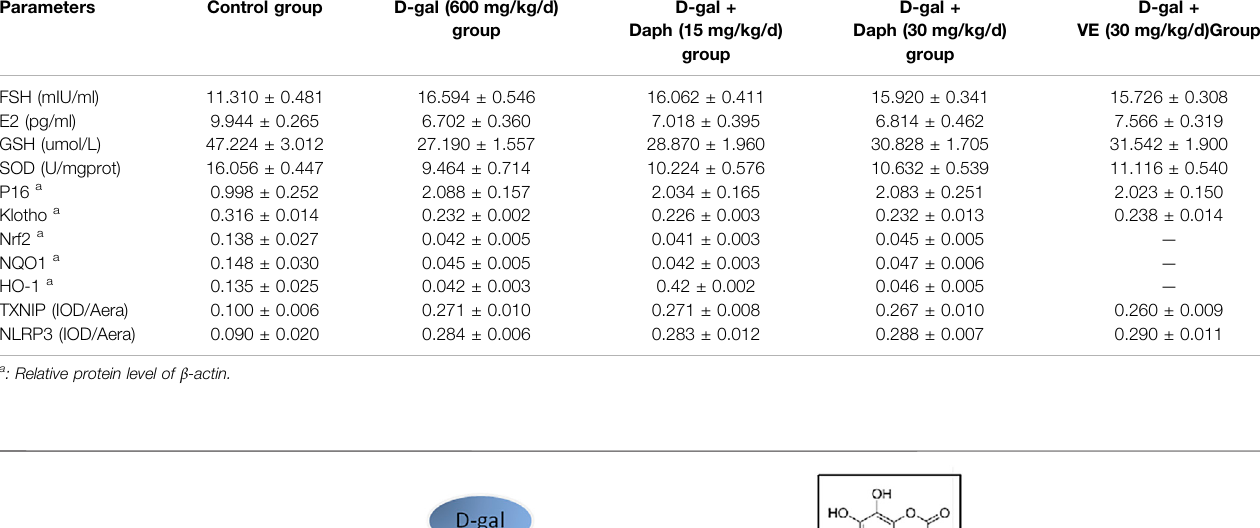
TABLE 2 | Daph ’ effect in Nrf2 Knockout mice. Parameters